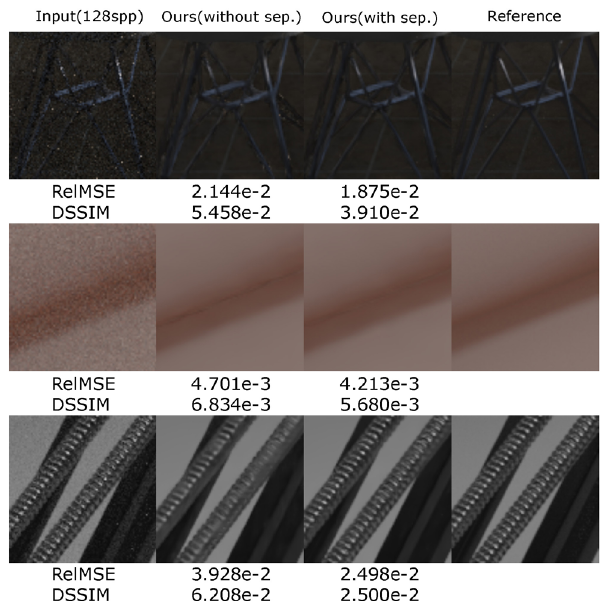
Fig. 11 Our method with and without perceptual loss (PL).